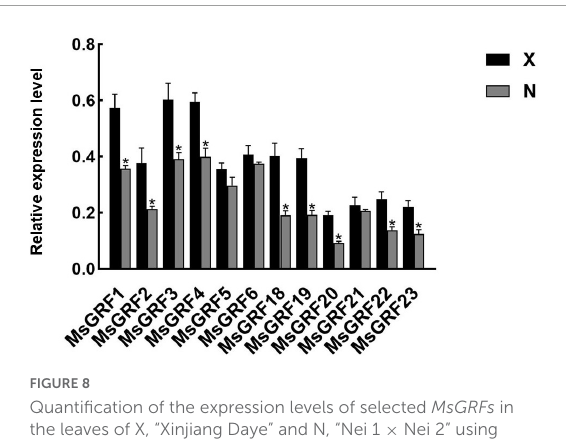
FIGURE8 Quantification of the expression levels of selected MsGRFs in the leaves of X, “Xinjiang Daye” and N, “Nei 1 × Nei 2” using qRT-PCR. Vertical bars indicate standard deviation. The asterisk (*) indicates the significant difference at P < 0.05 by Student’s t